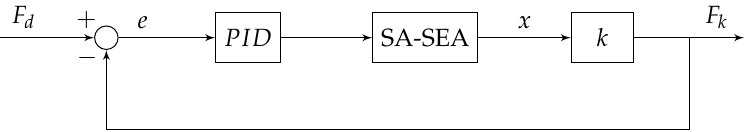
Figure 7. Force controller for high impedance RFSEA